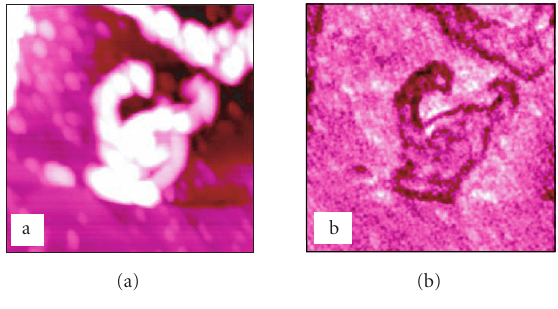
Figure 2: Simultaneous AFM (a) (11 μ m, Z range 500nm) and SNOM (b) of a partly autoxidized (001)-face of 2-mercaptobenzot- hiazole ( 1 ) showing islands and negative chemical contrast precisely at the island sites of 2